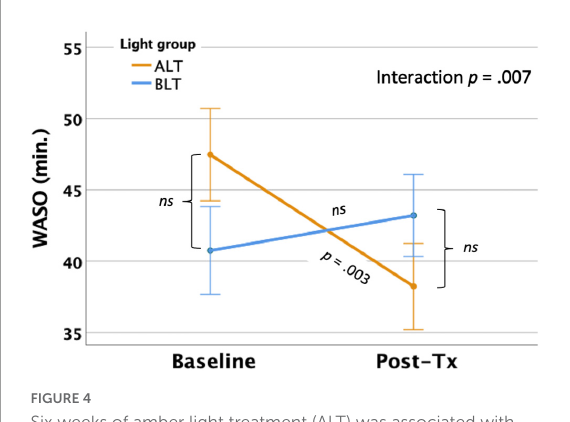
Error bars = ± 1 SE. Post hoc comparisons are Bonferroni